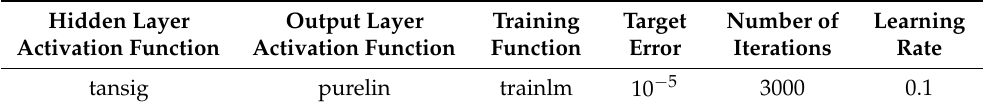
Table 4. BPNN parameters.